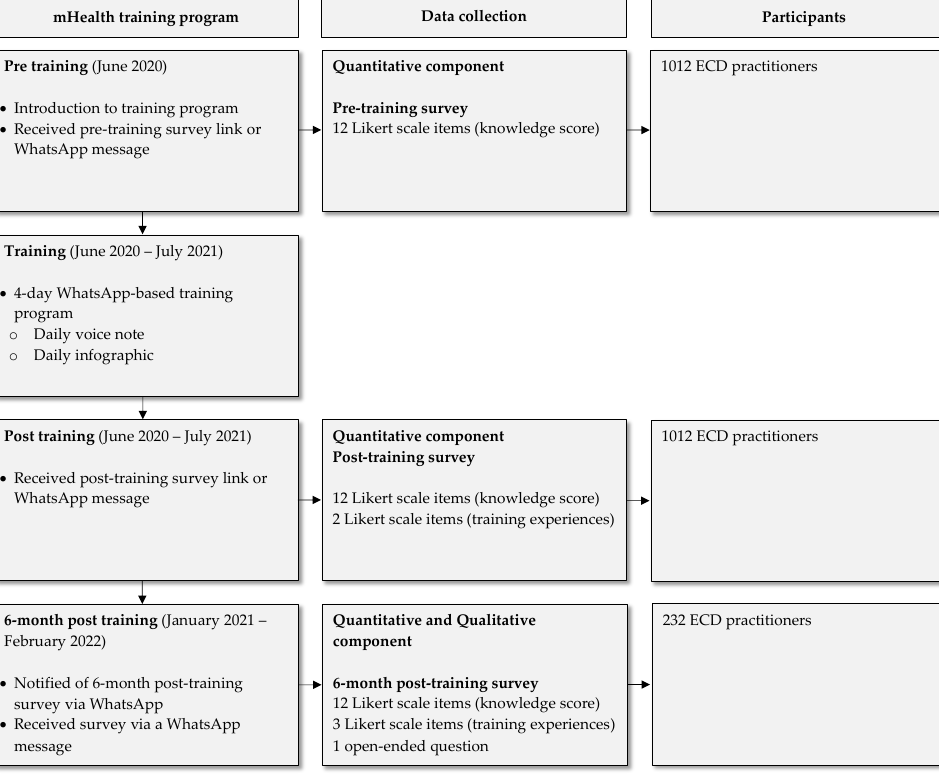
Figure 1. Data collection procedures linked to the mHealth training